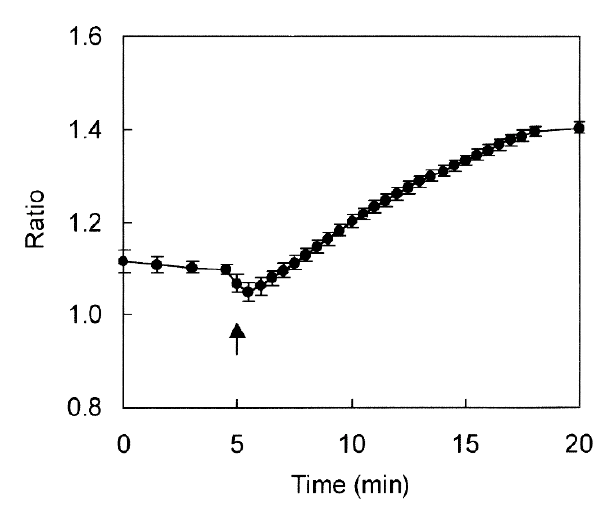
Figure 4 Changes of [Ca 2+ ] i level in SaOS-2 cells kept under pressure (1 atm) following ethylene gas exposure. Ethylene gas was injected into the pressure chamber 5 min after starting fluorescence measurements (arrow). The val- ues for the ratios of the 340/380 nm images are shown. The results are expressed as mean values ± S.E.; n = 20.